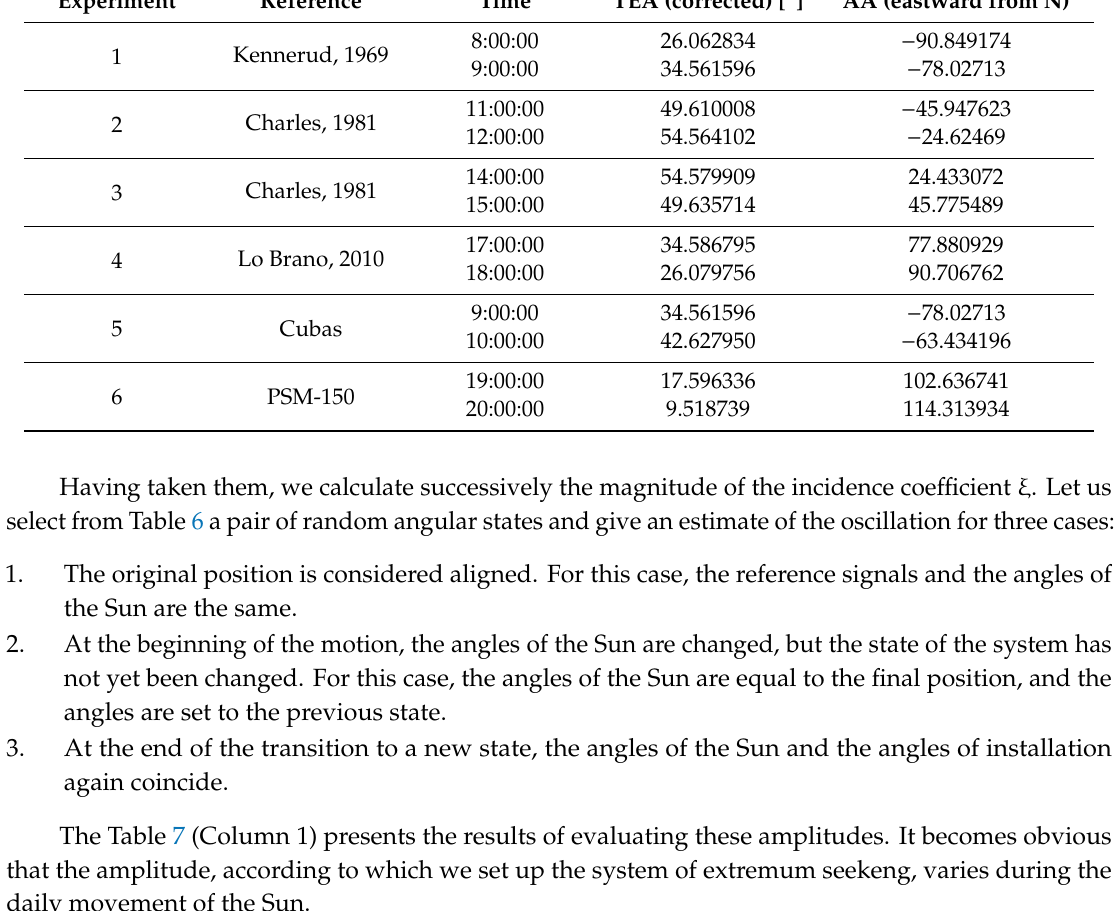
Table 6. Allocated time intervals for modeling extremum seeking control systems in Chelyabinsk on July 15, 2019 from 8:00 AM to 8:00 PM according to NREL MIDC SPA.